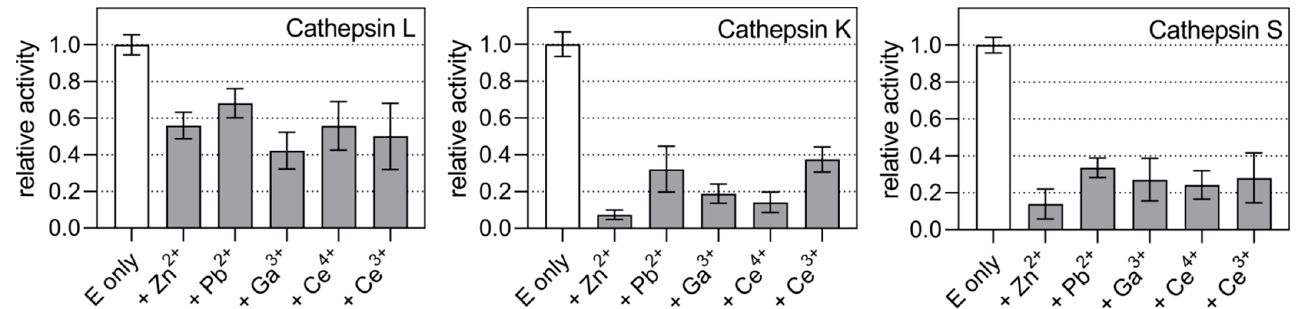
Figure 6. Inhibition of bovine neck ligament elastin degradation by selected metal ions. Plots show relative enzyme activities normalized to the activities of each cathepsin in the absence of metal ions. Final concentrations of metal ions and peptidases in the reaction mixtures were 0.2 µM and 0.5 mM, respectively. The concentrations of the degradation products were measured after their derivatization with fluorescamine, as described previously [51]. The error bars represent the S.E.M. of at least three replicates.